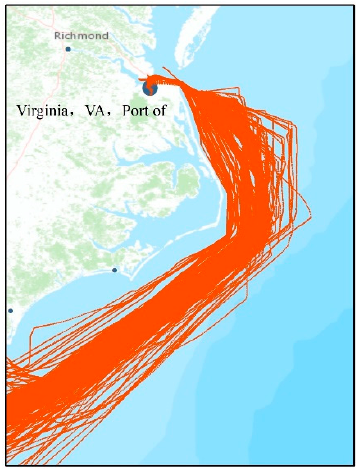
Figure 5. The study region (from N31.8° to N37.3° and W74.3° to W78°) and trajectory data generated by vessels traveling back and forth between the Florida Strait and Port of Virginia from 1 May to 31 August, 2014.